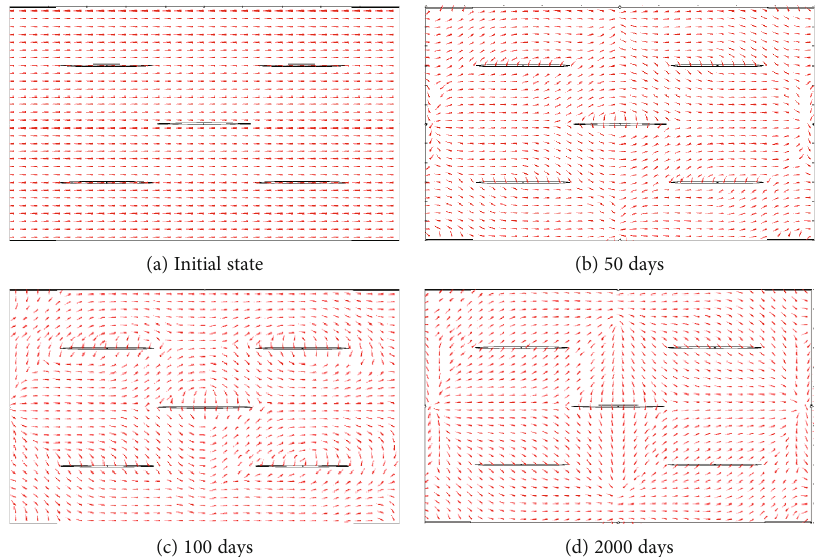
Figure 12: Maximum stress direction in di ff erent developing periods.